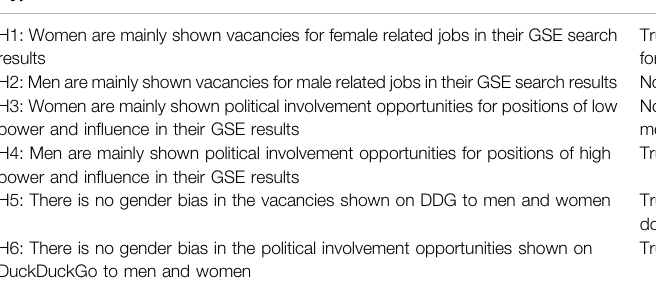
TABLE 6 | Summary of fi